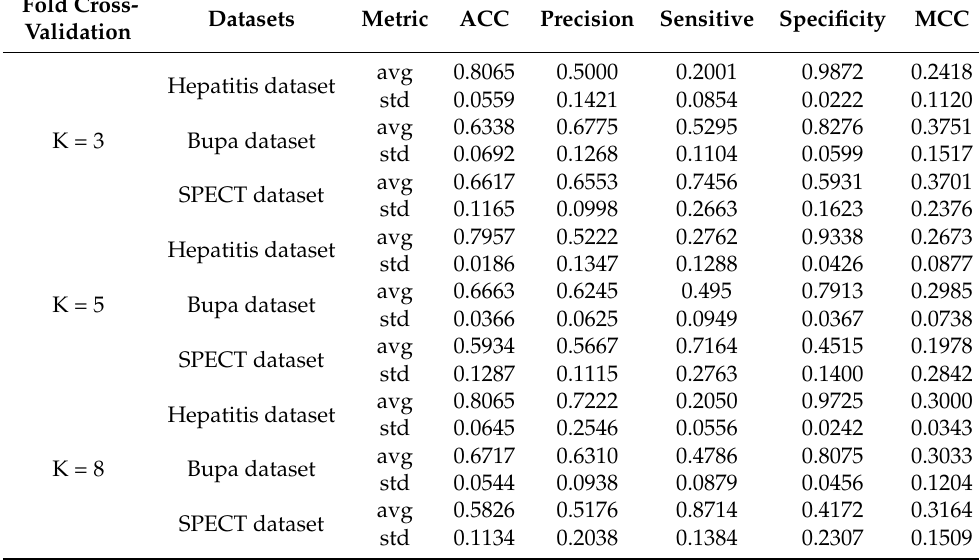
Table A2. Numerical results for three two-class datasets in different-fold cross-validation